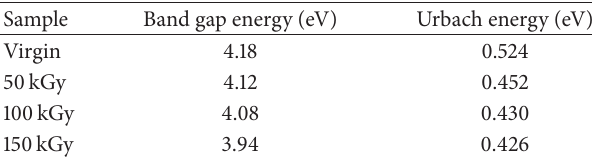
Table 2: Band gap energy and Urbach energy of virgin and electron irradiated silk fibroin films.